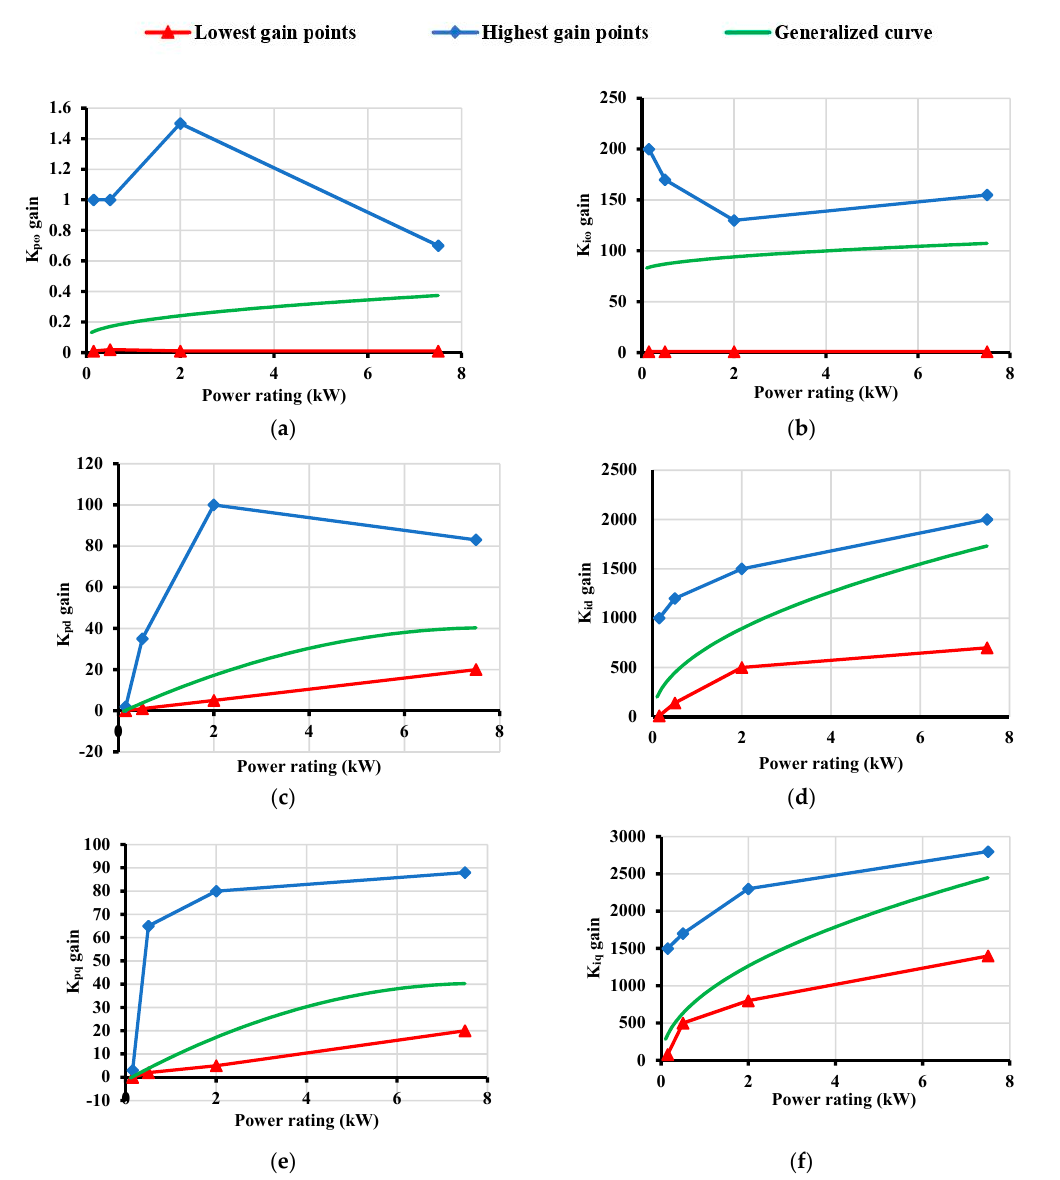
Figure 5. PI control gains versus motor power ratings. ( a ) K p ω ; ( b ) K i ω ; ( c ) K pd ; ( d ) K id ; ( e ) K pq ; ( f ) K iq . The non-linear generalized curve allows better precision in the tracking of the speed and d-q axis currents which is also justified by the non-linear nature of the PMSM’s